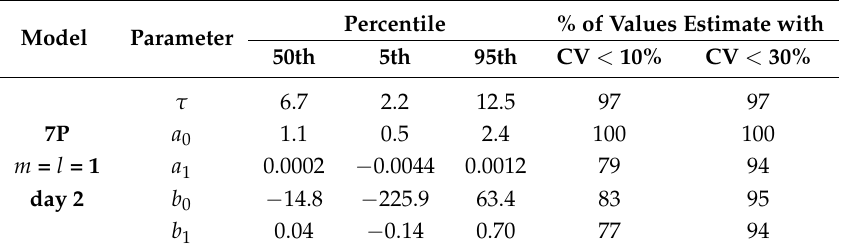
Table 5. The 50th, 5th, and 95th percentile values for the parameters of the Dexcom SEVEN PLUS (7P) sensor and percentage of values estimated with a coefficient of variation lower than 10% and 30%.